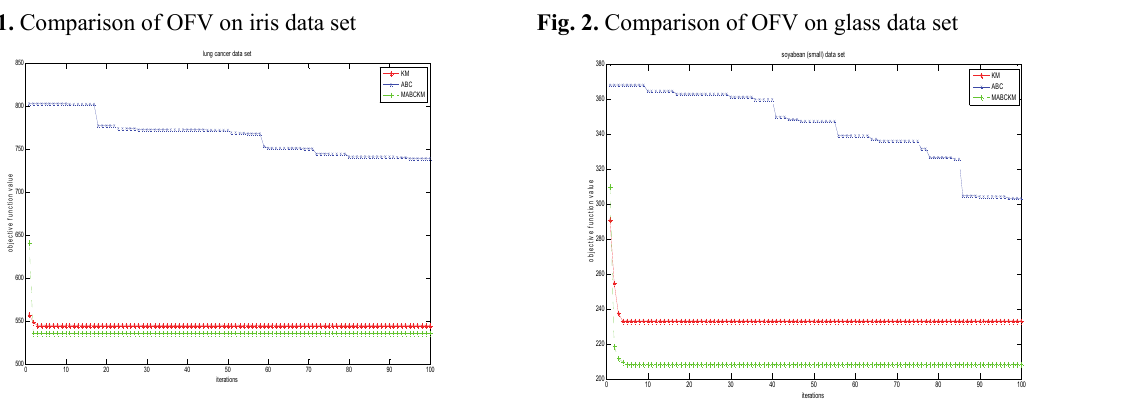
Fig.1. Comparison of OFV on iris data set Fig. 2. Comparison of OFV on glass data set